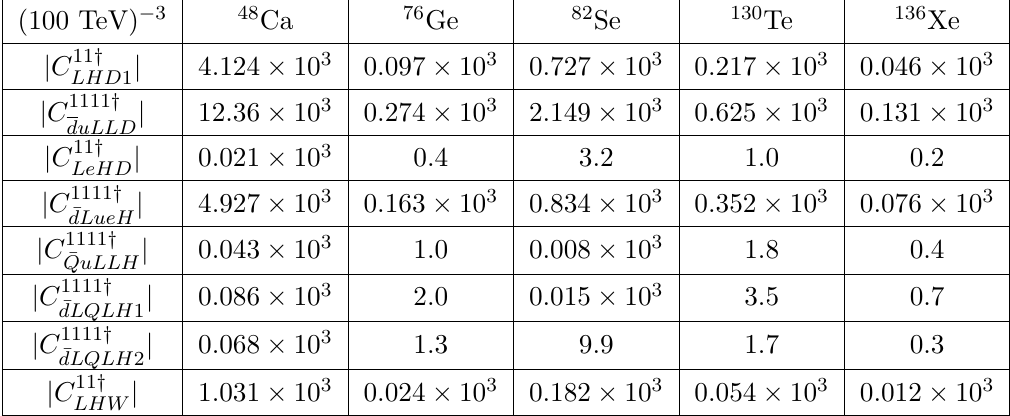
Table 5 . Upper bounds on Wilson coe(cid:14)cients of dim-7 operators at the weak scale (cid:22) (cid:25) m W using RGE formulas in ref. [28] and table 4 as initial values